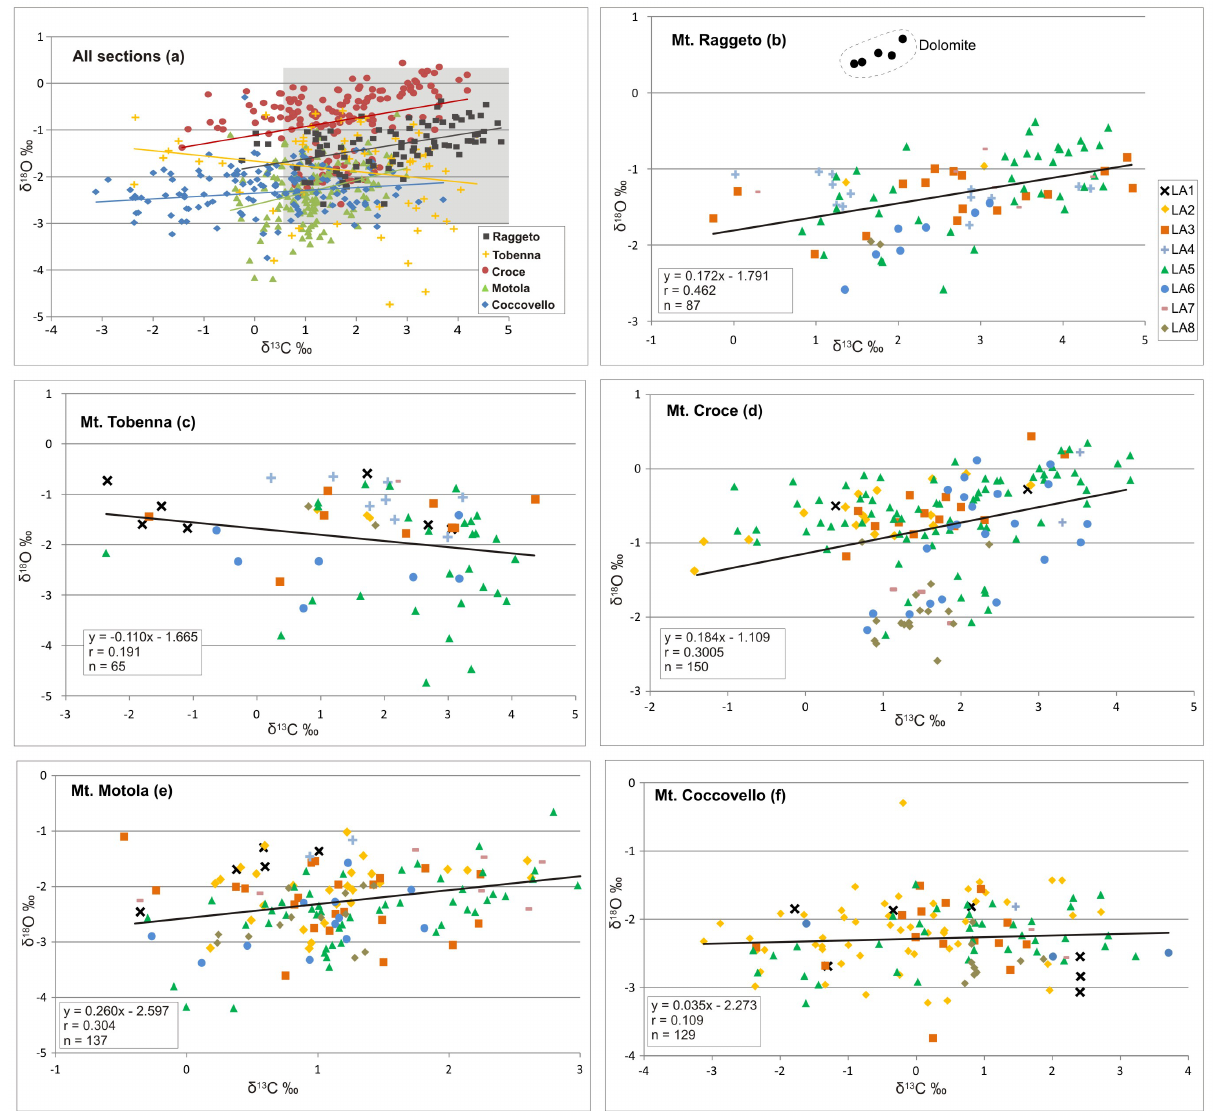
Fig. 13. Cross-plots of δ 13 C vs. δ 18 O for the whole dataset (a) and for each studied section (b–f) . The all-lithofacies dataset (a) shows very low to moderate covariance ( r = 0 . 01 − 0 . 46). Supratidal and intertidal lithofacies associations show higher covariance of stable isotope ratios (diagrams b–c; see also Table 3. On the other hand, there is no clear relation between lithofacies and isotopic value. The shaded rectangle in diagram (a) indicates the range of well-preserved biotic calcite of shallow marine tropical-subtropical carbonates (from Prokoph et al.,